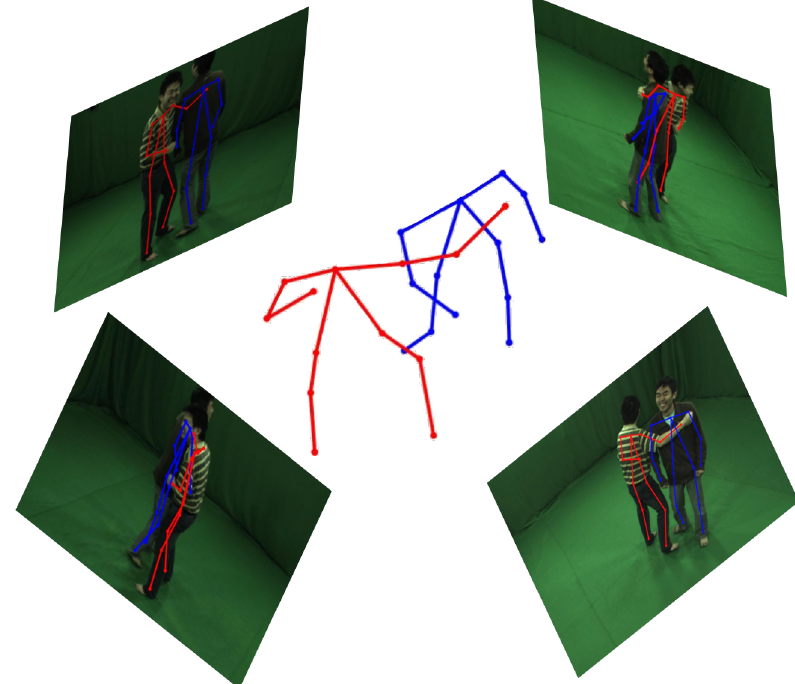
Figure 1. 3D pose detection result of multiple markerless persons with close interactions from multi-view images at one time instance. Visualized results are shown as 2D poses in every view image reprojected from 3D